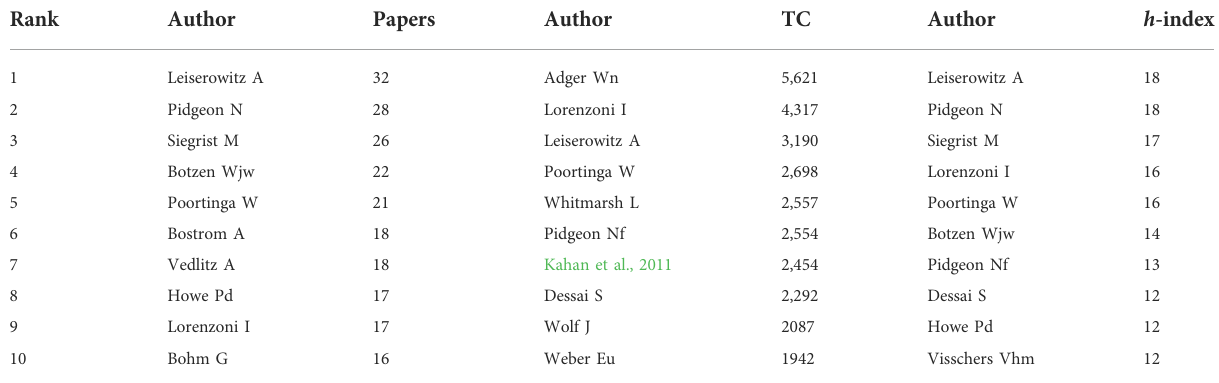
TABLE 3 The top 10 authors regarding the number of papers, total citations and